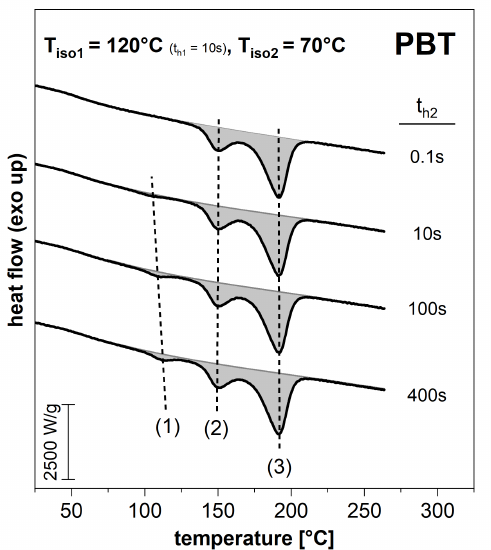
Figure 8. Exemplary first heating runs (at 1000 K/s) after the primary and subsequent secondary crystallization at 120 °C and 70 °C, respectively, obtained with the FSC. The holding time t h at 120 °C was 10 s, whereas it varied at 70 °C in the range from 0.1 to 400